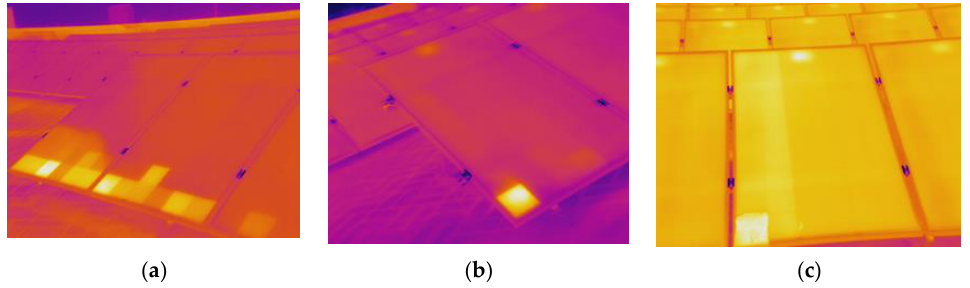
Figure 3. Infrared (IR) thermographic images of PV panels under partial shading showing hotspots: ( a ) shading from the panel in the front row, ( b ) un-expected shading on a bottom left cell, and ( c ) shading caused whole PV sub-module bypassed.